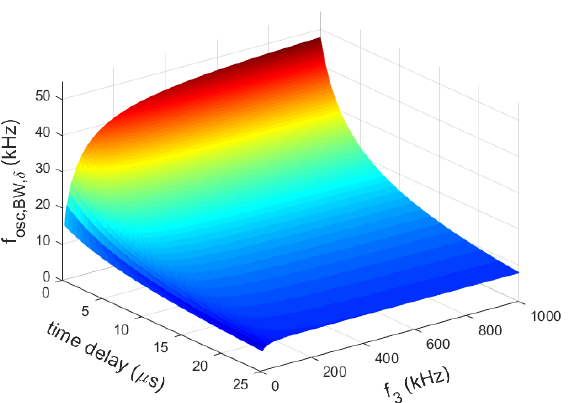
Figure 7. Evolution of the maximum oscillation frequency under PSSOCC control, as a function of the time delay and the current sensor bandwidth ( 𝑓 𝑜 = 50 𝑘𝐻𝑧 ; 𝜉 = 1 ; 𝜏 1 = 3.6 𝑚𝑠 ). It clearly appears from those results that the minimization of the time delays and the use of a high bandwidth for the current sensor are fundamental in order to increase the maximum switching frequency. Eventually, the knowledge of the current sensor band- width and a good estimation of the system time delays permits to precisely determine the maximum switching frequency of the power converter controlled by PSSOCC. It should be noted that the aforementioned theoretical approach does not depend on the power converter topology since the PSSOCC is extremely robust.